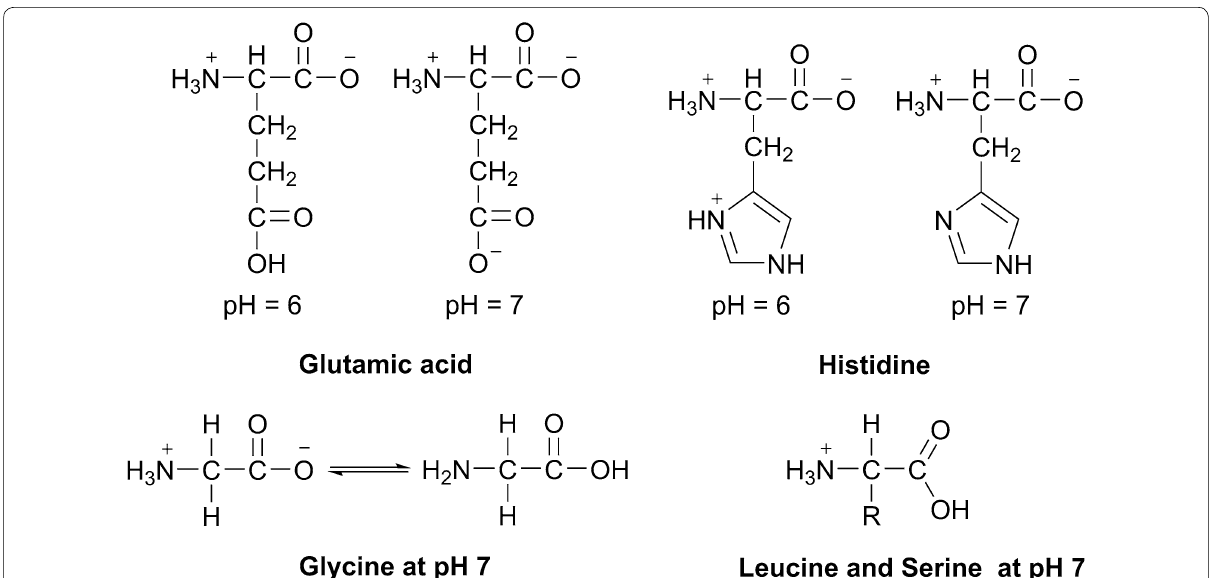
Fig. 4 Charge state of different amino acids. R